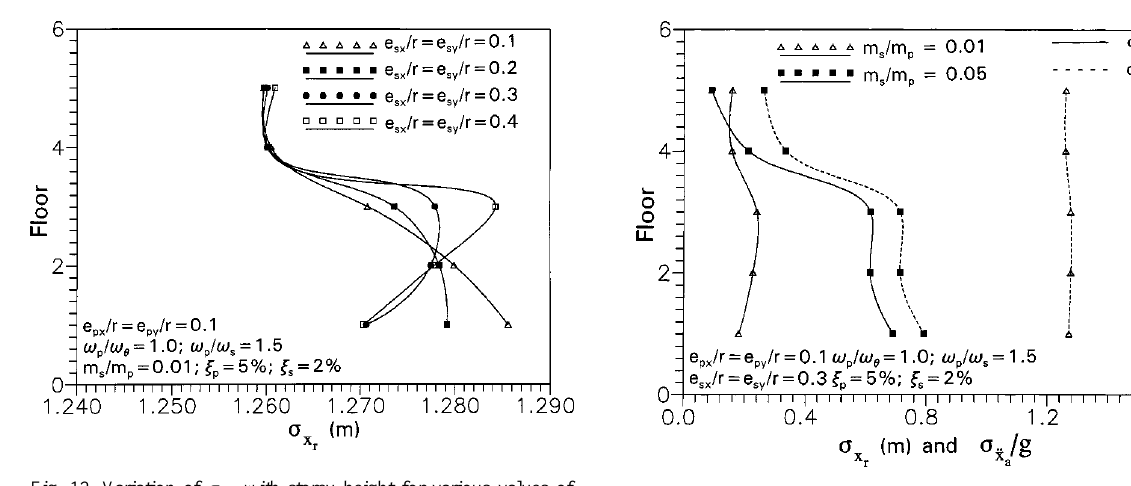
=g with storey height for Fig. 14. Variation of (cid:27) x and (cid:27) (cid:127) x r a e p x =r = e p y =r = 0.1; for m s =m p = 0.01, 0.05; ! p =! s = 1.5; ! p =! (cid:18) = 1.0; e s x =r = e s y =r = 0.3; (cid:24) p = 5% and (cid:24) s = 2%.